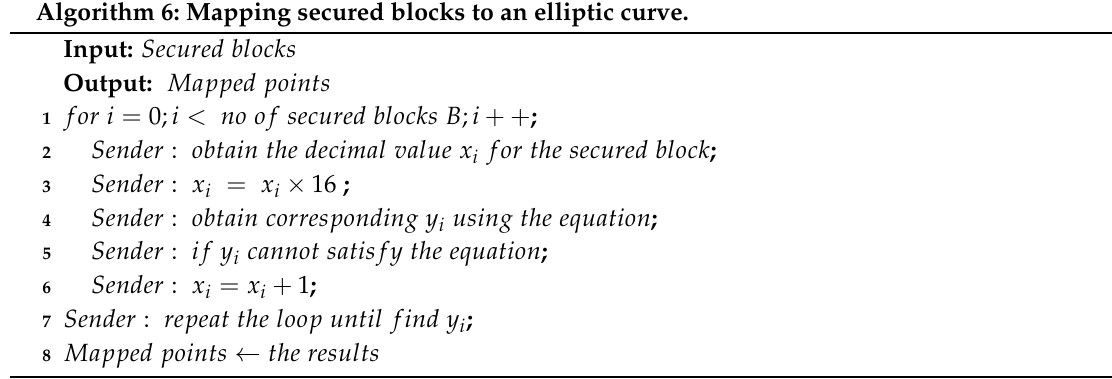
Algorithm 6 outlines the steps involved in mapping the secured blocks to an elliptic curve. Algorithm 6: Mapping secured blocks to an elliptic